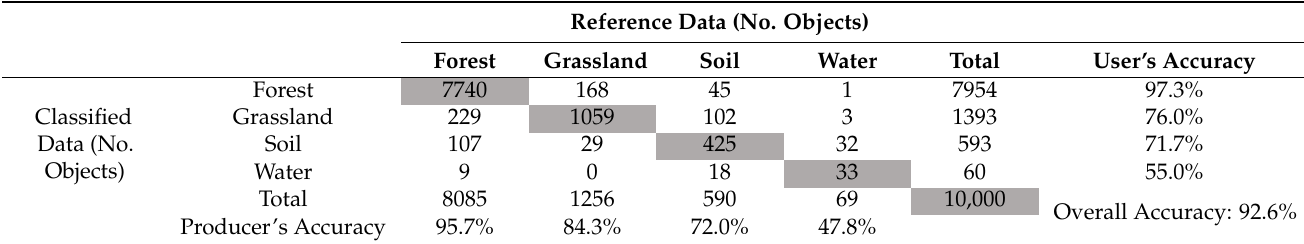
Table 7. Confusion matrix for the SVM classification trained from 40 samples graphed in Figure 5. Reference Data (No.